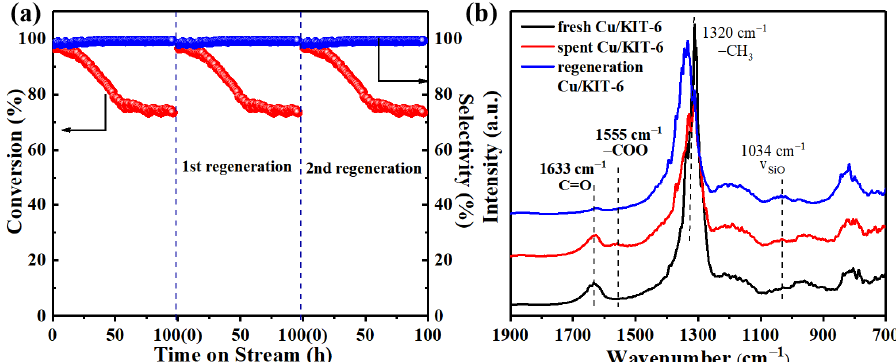
Figure 9. ( a ) Long time stability of the Cu/KIT-6 catalyst at 250 °C. Reaction condition: a reactant ethanol stream of 2 kPa balanced by N 2 under atmospheric pressure and WHSV of 13.67 mmol g −1Cu h −1 . Regeneration condition: oxidation at 250 °C for 1 h under 20% O 2 /N 2 . ( b ) In situ FTIR spectra of the fresh catalyst, spent catalyst, and regenerated catalyst.